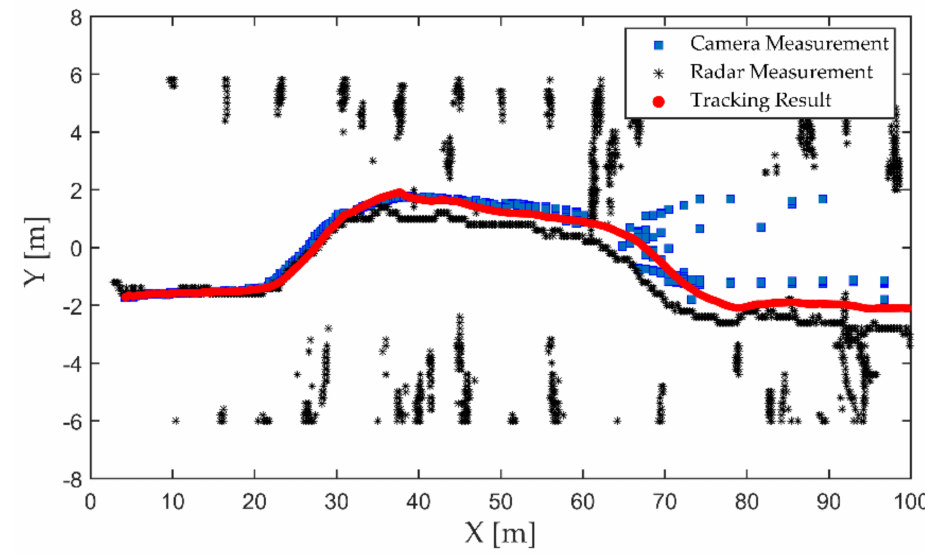
Figure 15. Vehicle detection and tracking results.